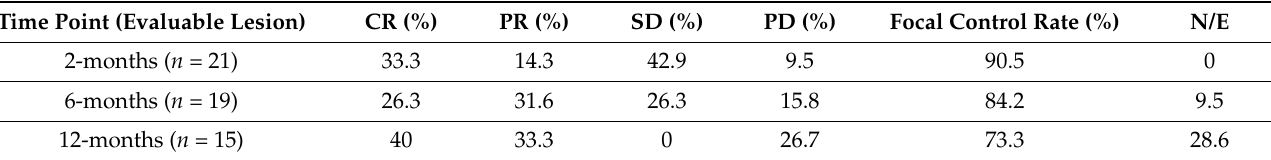
Table 2. Objective response rates at 2, 6 and 12 for PM.